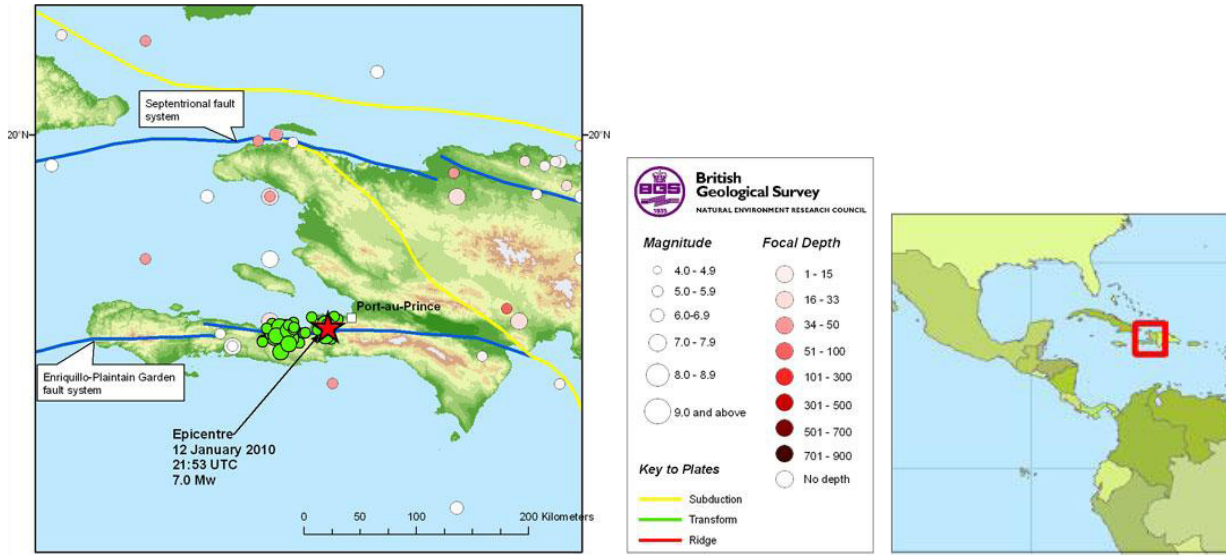
Figure 1a. Showing location of epicenter of Haiti earthquake event of 12 January 2010. (Source - http://www.bgs.ac.uk/research/highlights/haitiEarthquakeJan2010.html) Fig. 1a. Showing location of epicenter of Haiti earthquake event of 12 January 2010 (source: http://www.bgs.ac.uk/research/highlights/ haitiEarthquakeJan2010.html).